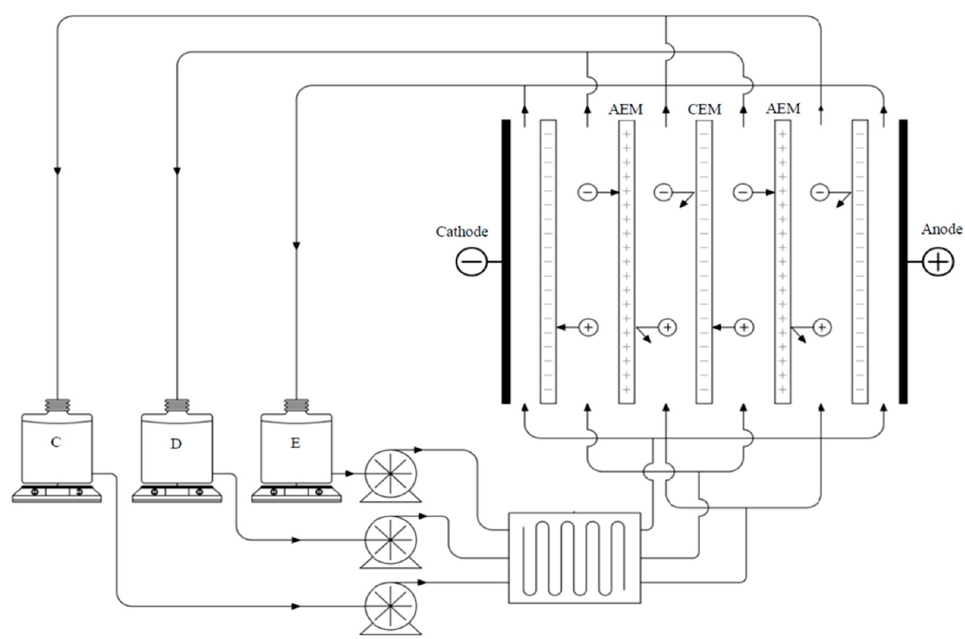
Figure 2. The experimental arrangement used for the electrodialysis (ED) experiments ((C = con- centrate, D = diluate, E = electrolyte, CEM = cation exchange membrane, AEM = anion exchange membrane).